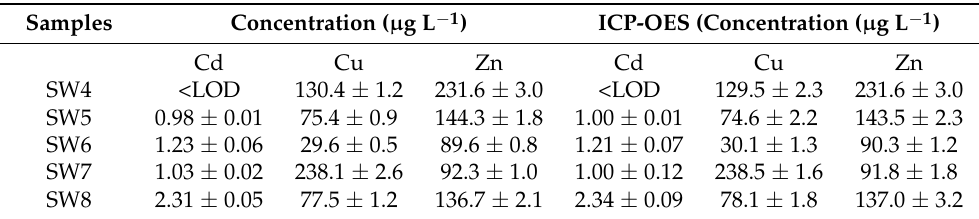
Table 5. Simultaneous determination Cd, Cu, and Zn ions in real surface water samples using